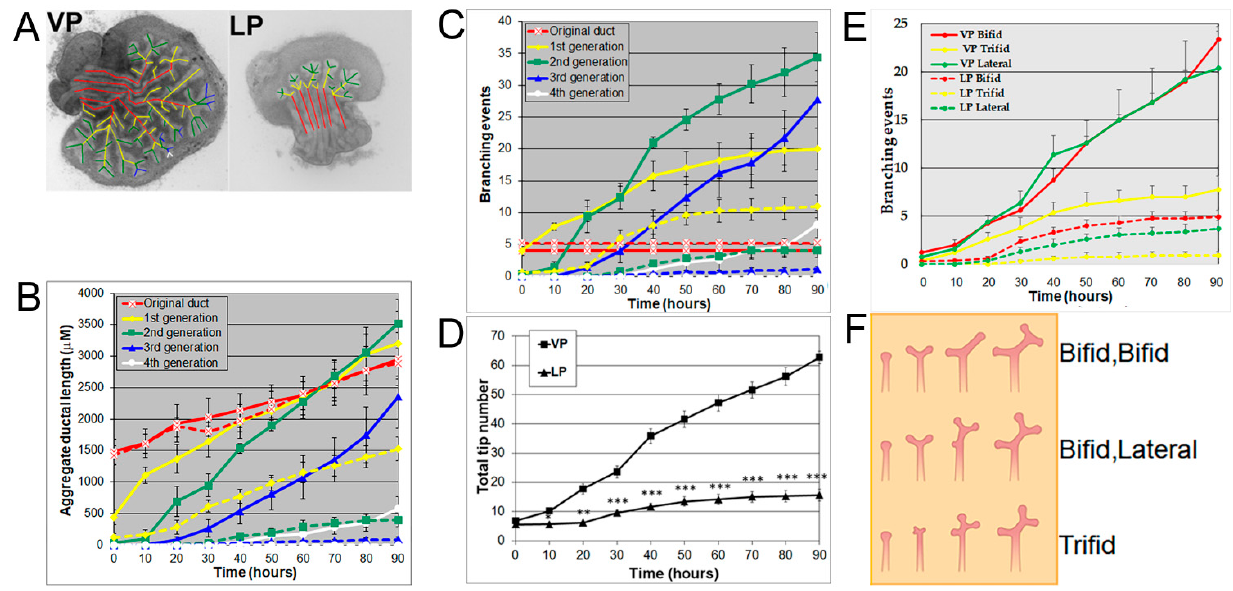
Figure 1. ( A ) Branch generations of pnd 0 cultured rat VP (left) and LP (right) lobes. Successive images were taken every 30 min for 90 h to track branching events. Representative end-point images at 90 h are shown. A color-coded skeleton is used to indicate branch generations according to the following convention: the primary buds emerging from the UGS are considered the original ducts (red); branches that form off the primary ducts are considered the first generation (yellow); branches that form off the first generation and elongate are considered the second generation (green), third generation (blue), and fourth generation (white). Note that VPs formed branches up to the fourth generation, while LPs stopped branching at the second generation. ( B ) Kinetics of prostatic bud and ductal elongation and successive branch generations in pnd 0 rat VPs and LPs cultured for 90 h. The aggregate length ( μ m) of all ductal segments in each successive branch generation over time is shown. Solid lines represent VP data and dashed lines represent LP data. ( C ) Total number of branch point events in each ductal generation as a function of time. Solid lines represent VP data and dashed lines represent LP data. Error bars denote SEM from 5 sets of experiments. Differences between the two groups are statistically significant ( p < 0.05) from 40 h onward except for the original ducts. ( D ) Total tip number in 3D analysis as a function of time in rat pnd 0 VPs (squares) and LPs (triangles) cultured for 90 h. Each data point represents the mean of 5 sets of experiments and bars denote SEM. * denotes significant differences between VPs and LPs, * p < 0.05, ** p < 0.01, *** p < 0.001. ( E ) Total counts of specific branching types (terminal bifeds, terminal trifeds, lateral side branches) occurring over time in VPs vs. LPs. Each data point represents the mean of 5 sets of experiments, and bars denote SEM. Differences between VPs and LPs are statistically significant ( p < 0.05) from 30 h onward. ( F ) Illustration of three branching types: terminal bifeds, terminal trifeds, and lateral side branches. The branching schematic at the far right is identical in each row. However, they each came about through 3 different sequences of branching events over time: bifed-bifed, bifed-lateral, and trifed branching. Only sequence imaging over time can correctly clarify the specific branching events.